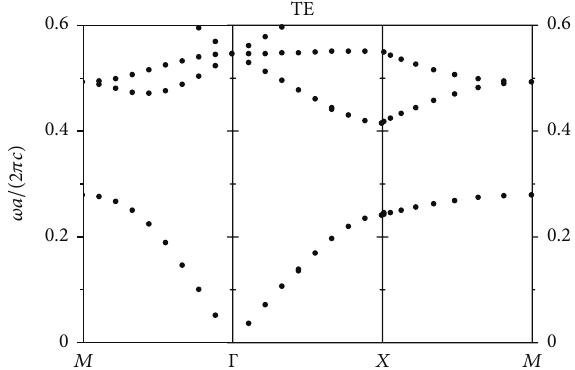
Figure 1: The TE mode photonic bands of two-dimensional pho- tonic crystals made by GaAs pillars in air with square lattice.